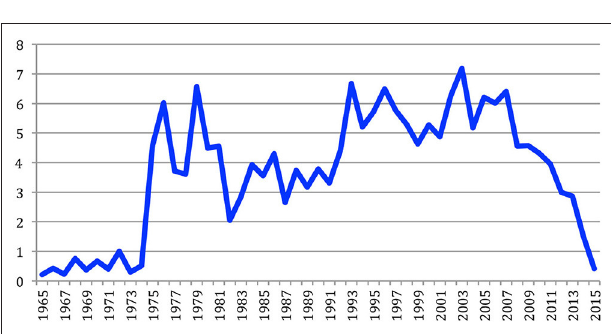
FIGURE 37 | Average number of citations per paper over the